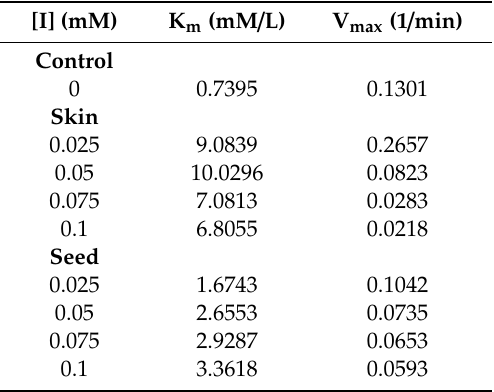
Table 4. Kinetic parameters of α -glucosidase inhibitory capacity by skin and seed extracts at the first stage of ripening.